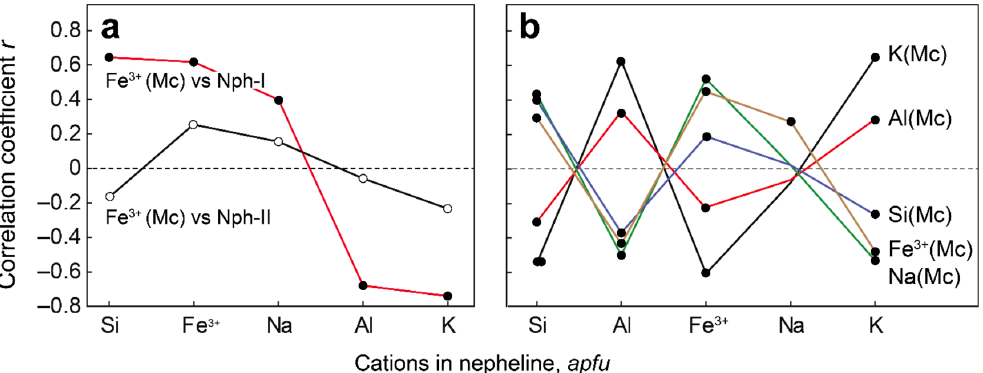
Figure 10. Results of factor analyses of data on the composition of nepheline from the Alliaiv site. Points on a gray background correspond to nepheline with inclusions of microcline and aegirine. Var.—variables; Expl.var.—Explained variance; Prp.totl—proportion of total variance. Factor loadings > |0.5| are shown in bold.